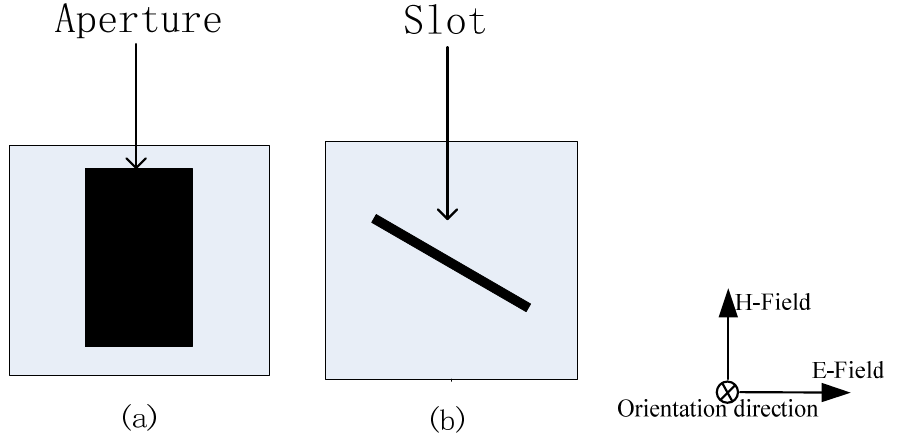
Figure 3. Typical HEMP coupling cases: ( a ) a cavity with an aperture; ( b ) a cavity with a slot. (f) The deviation mentioned in this paper denotes the deviation created by the